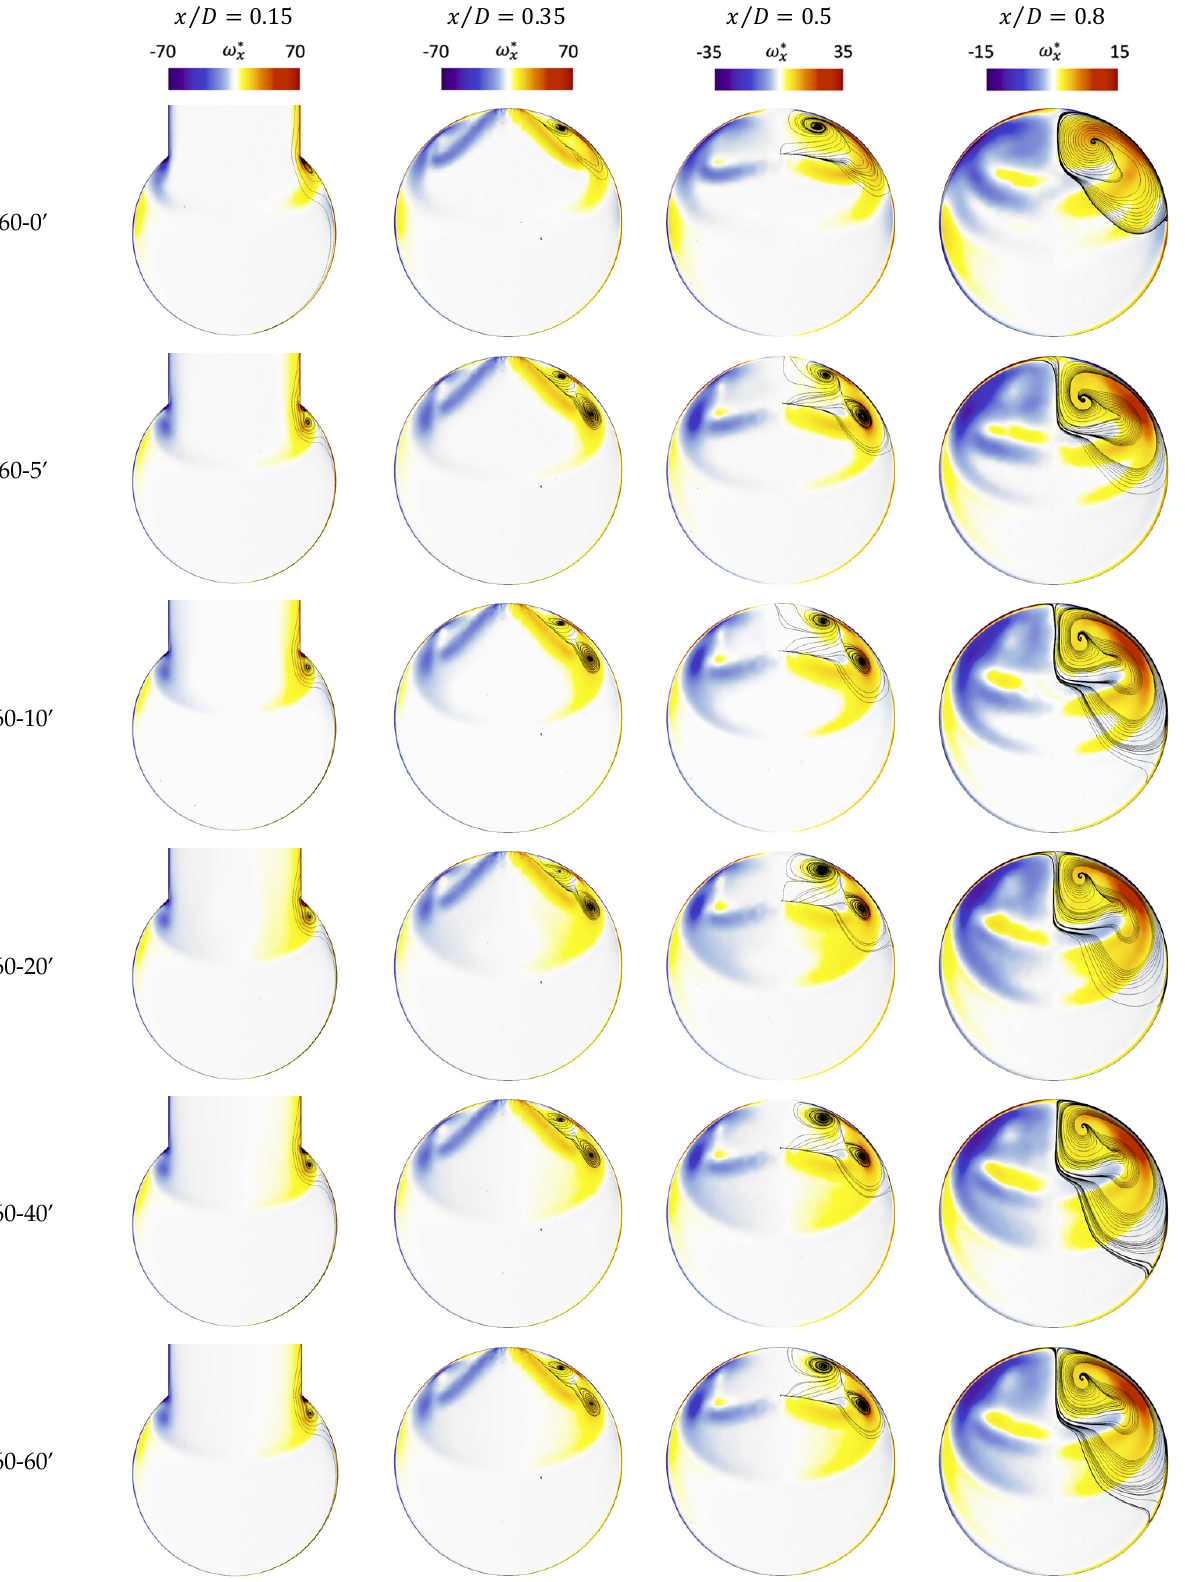
Figure 15. Contour plots of ω ∗ x with in-plane mean velocity streamlines (black lines) on different cross-sections for cases with fully developed BCs—Jet entrance and recirculation region.